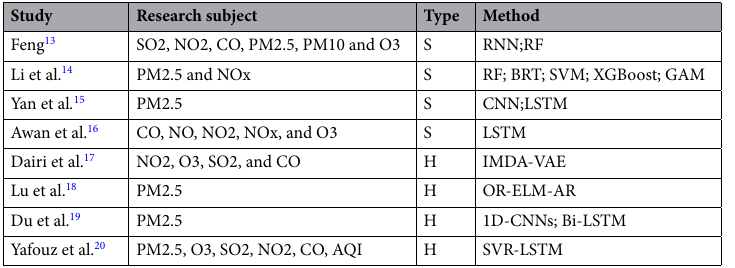
Table 1. Studies on forecasting air pollutants using different models. S : Single machine learning method, H : Hybrid machine learning